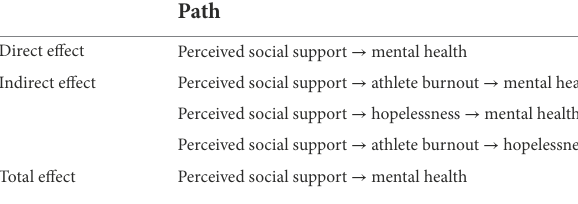
TABLE 3 Results of chain-mediated effect test ( n =